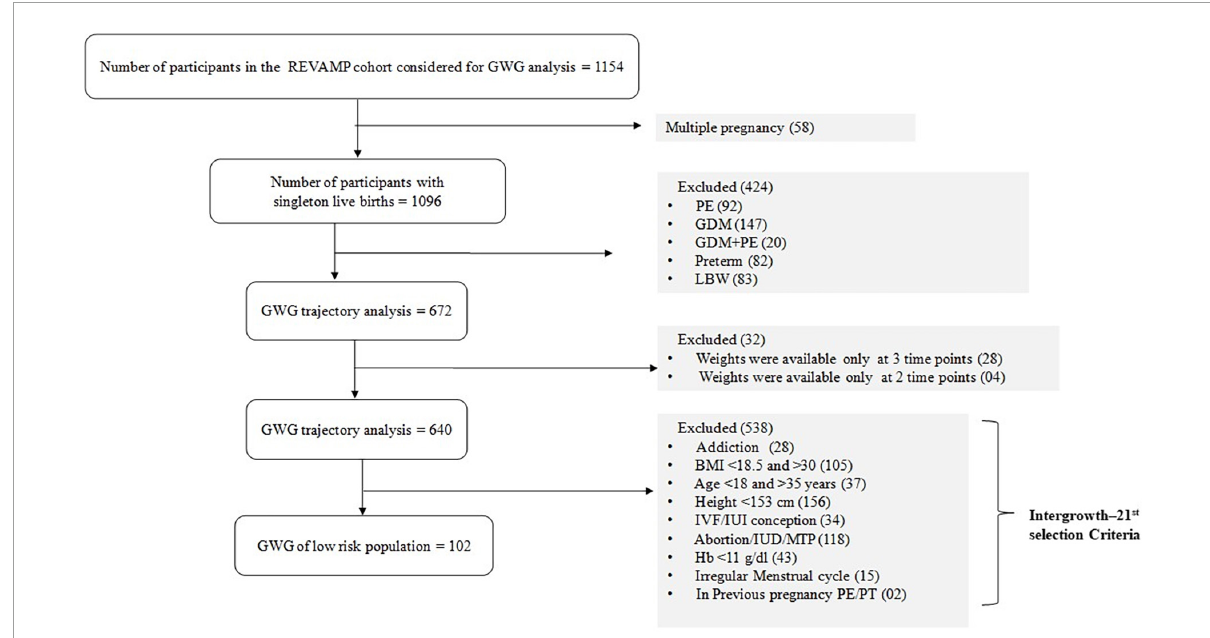
FIGURE1 Flow diagram of the selection of the study population from REVAMP pregnancy cohort for gestational weight gain. PE, preeclampsia; GDM, Gestational Diabetes Mellitus; LBW, Low Birth Weight; PT, pre-term; GWG, gestational weight gain; BMI, body mass index; IVF, in vitro fertilization; IUI, intrauterine insemination; Hb,